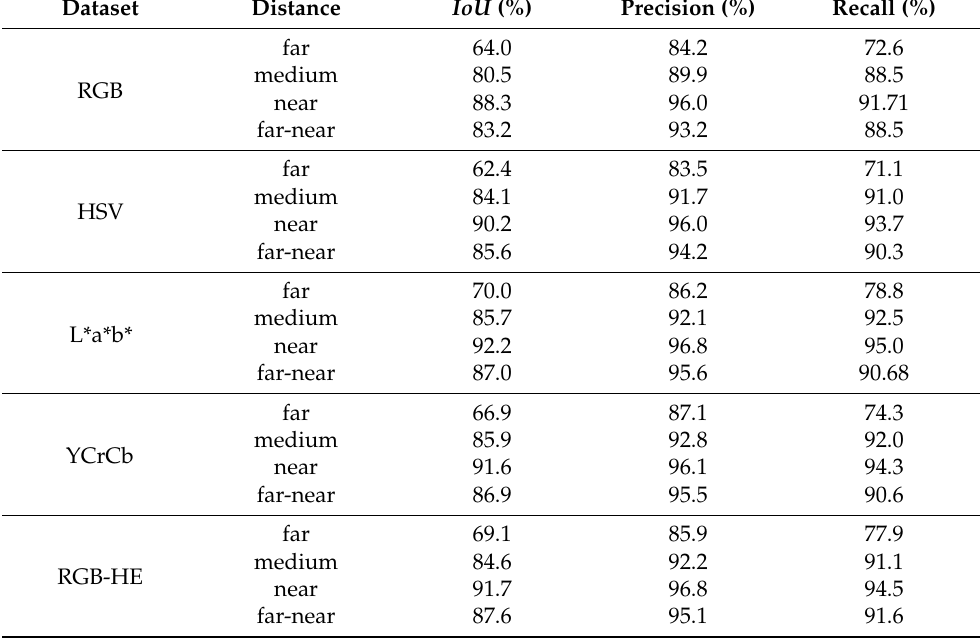
Table 7. The performance of samples at different distances in each testing dataset.